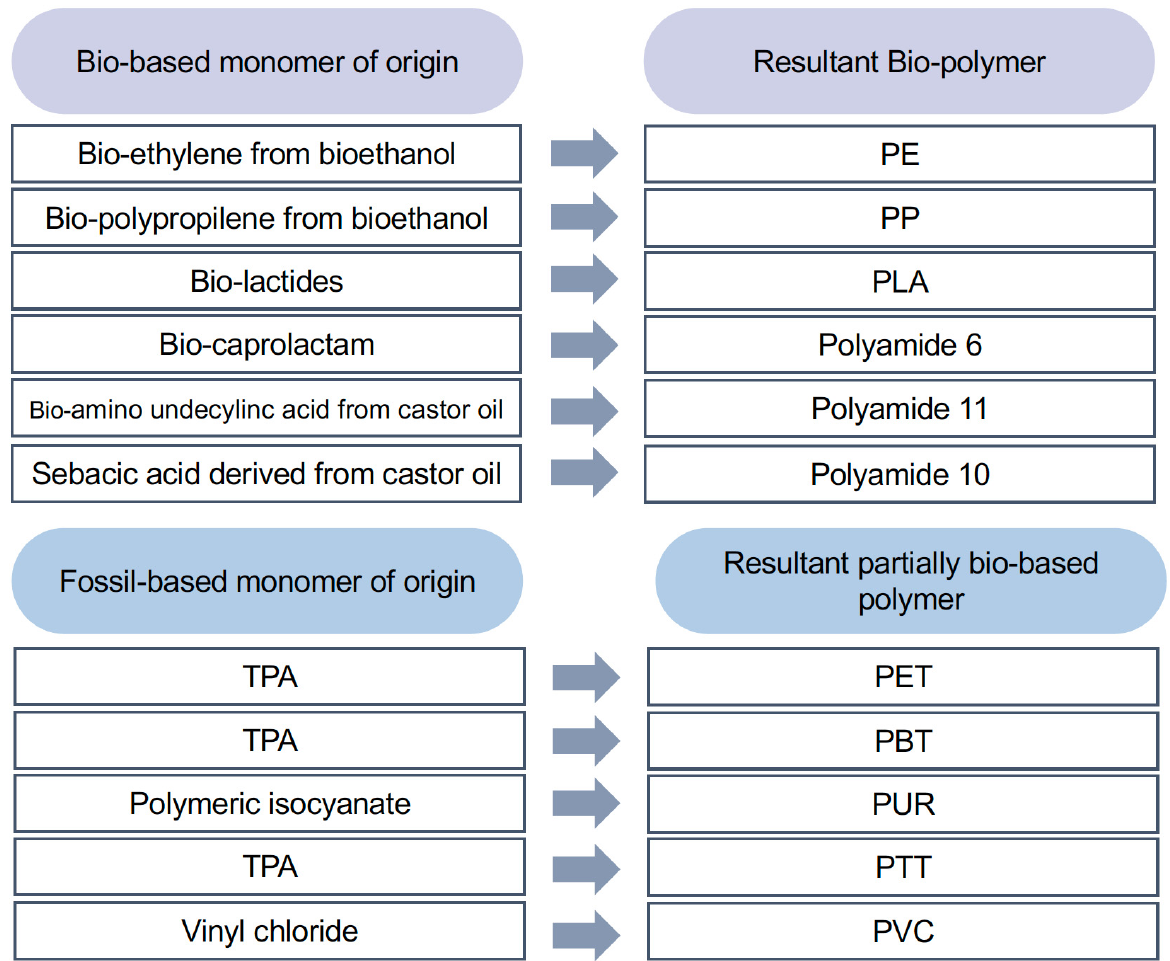
Figure 4. Bio-based and partially bio-based polymers suitable for automotive applications. PBS: poly(butylene succinate), PBT: polybutylene terephthalate, PLA: poly(lactic acid), PE: polyethylene, PET: poly(ethylene terephthalic acid), PP: polypropylene, PTT: polytrimethylene terephthalate, PUR: polyurethanes, PVC: polyvinyl chloride, TPA: thermoplastic polyamide.